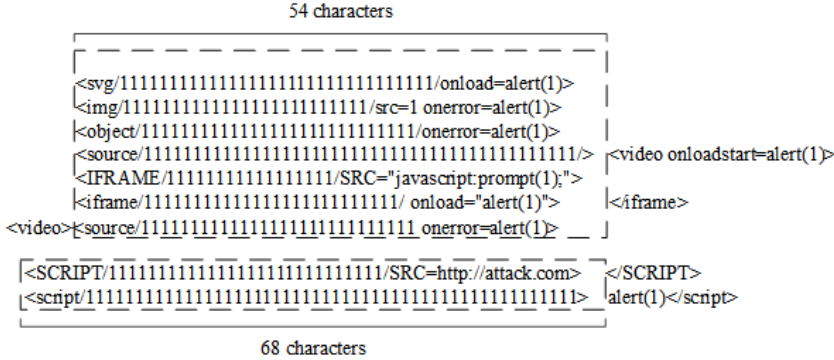
Figure 5. Examples of generic XSS escape strategies for